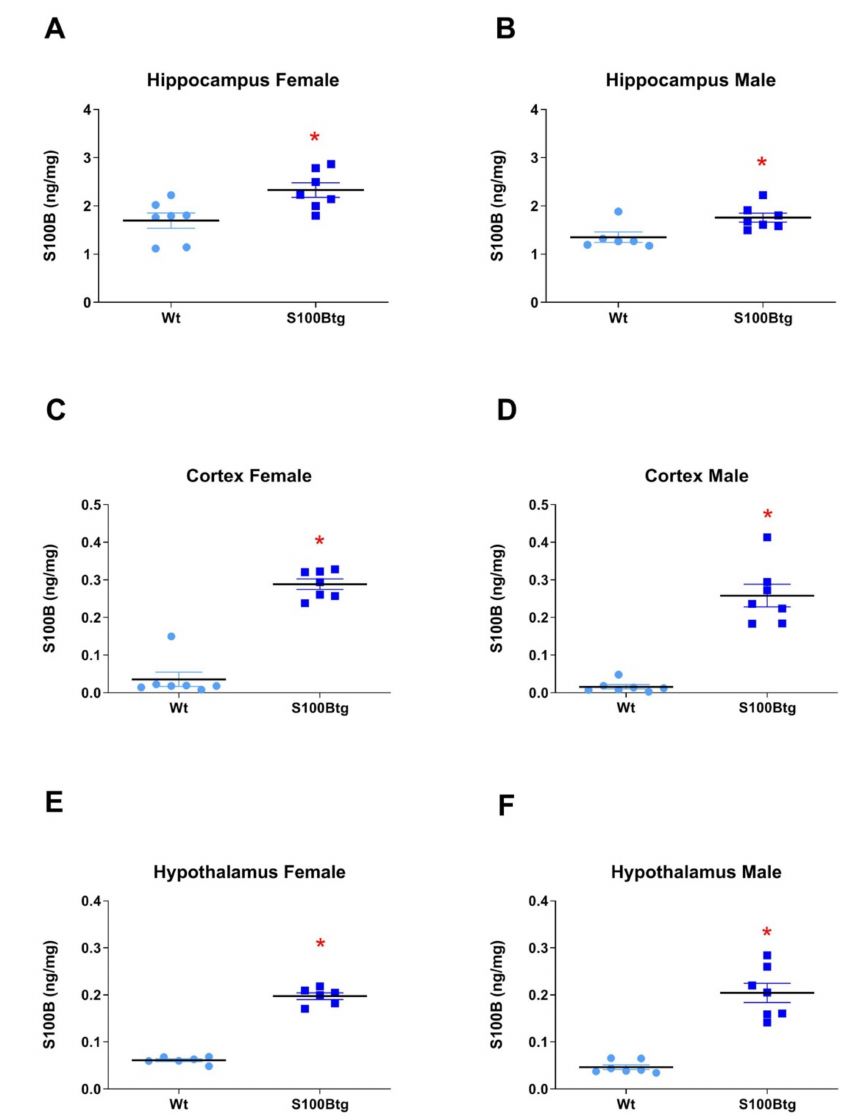
Figure 2. S100B brain content in one-year-old S100Btg and wt mice . S100B content was quantified in ( A , B ) hippocampus, ( C , D ) frontal cortex, and ( E , F ) hypothalamus; measurements were performed by ELISA. Data are expressed as means ± SE (7 mice/group). * indicates a statistically significant difference (Student’s t -test, assuming p <